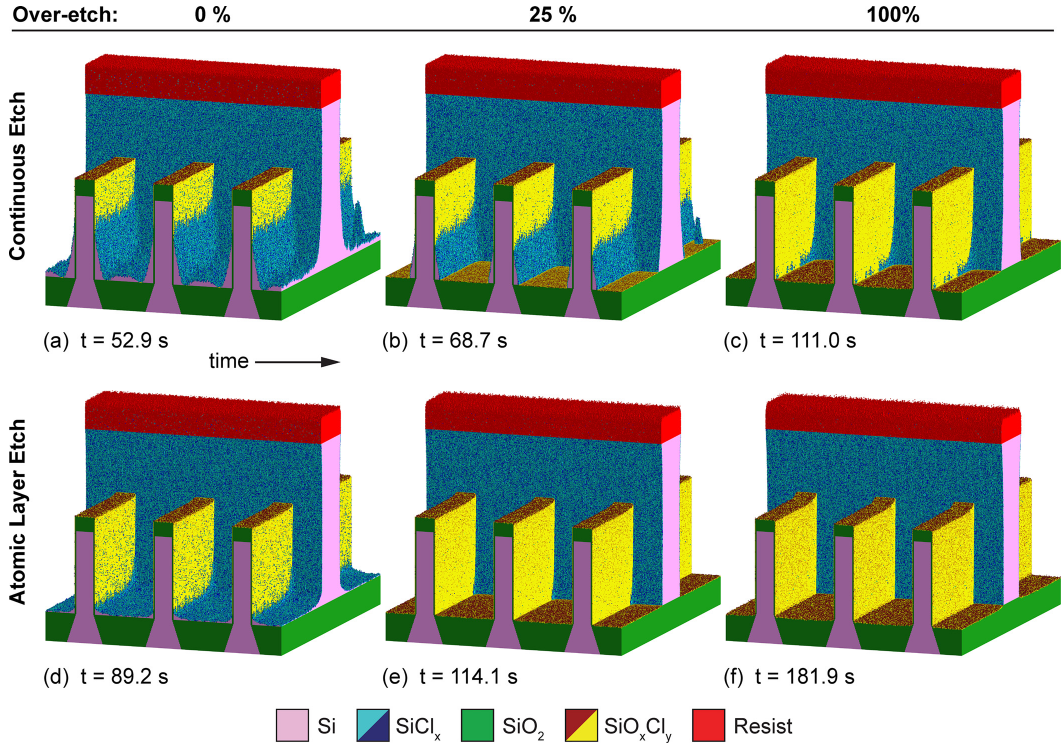
Figure 18. Profiles resulting from continuous Cl etching ( a – c ) and self-limited atomic layer etching using the same chemistry ( d – f ); used with publisher’s permission from